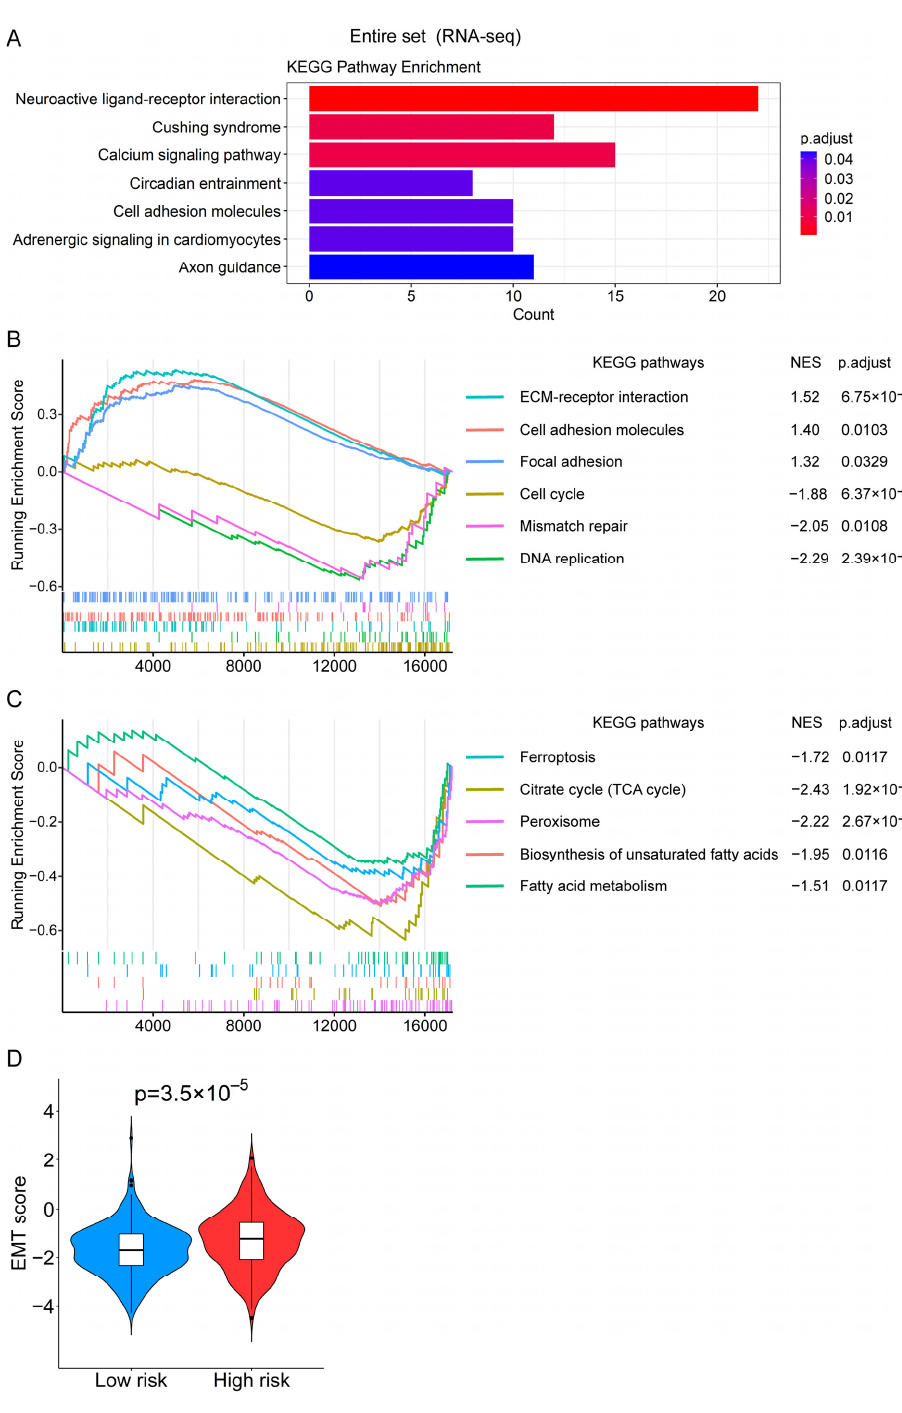
Figure 8. The possible biological processes related to the risk score revealed by the functional enrichment analysis. ( A ) The significantly enriched KEGG pathways of the differentially expressed genes between the high- and low-risk groups in the entire set. ( B ) The significantly enriched KEGG pathways between the high- and low-risk groups in the entire set based on the RNA-seq data through the GSEA analysis. ( C ) The “Ferroptosis” pathway and some metabolic pathways related to it are enriched in the low-risk group of the entire set based on the RNA-seq data via the GSEA analysis. ( D ) The violin plot shows the difference in EMT scores between the high- and low-risk groups in the entire